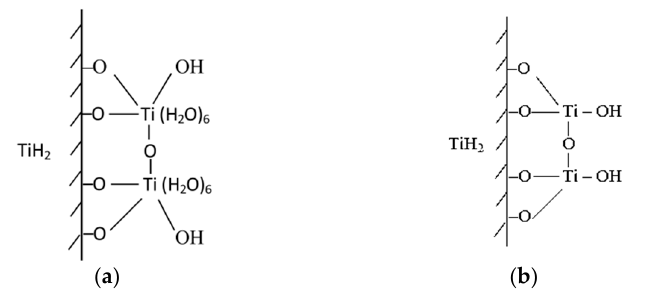
Figure 10. Screening of the titanium hydride ( a ) shot surface and formation of hydroxotitanyl ( b ) on the surface.